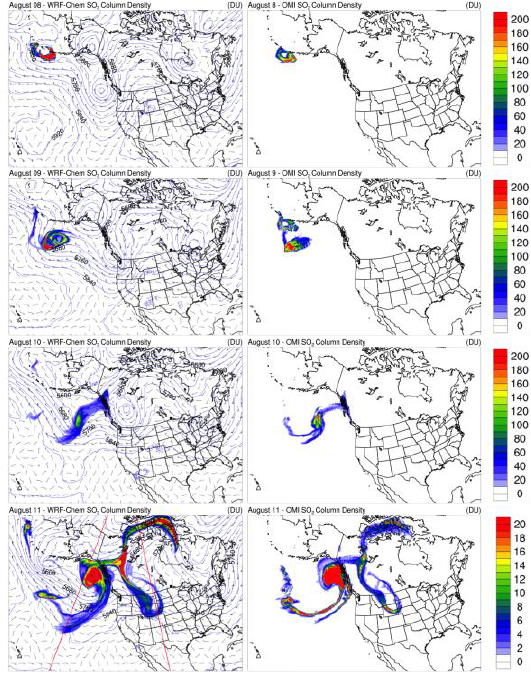
Figure 1: Dispersion of the Kasatochi SO 2 plume as mo- deled by WRF-Chem (left) and calculated by the OMI STL product (right). The transects used for spatial analy- sis are shown in red on the August 11 th plot. Geopoten- tial height and wind vectors are plotted on WRF-Chem